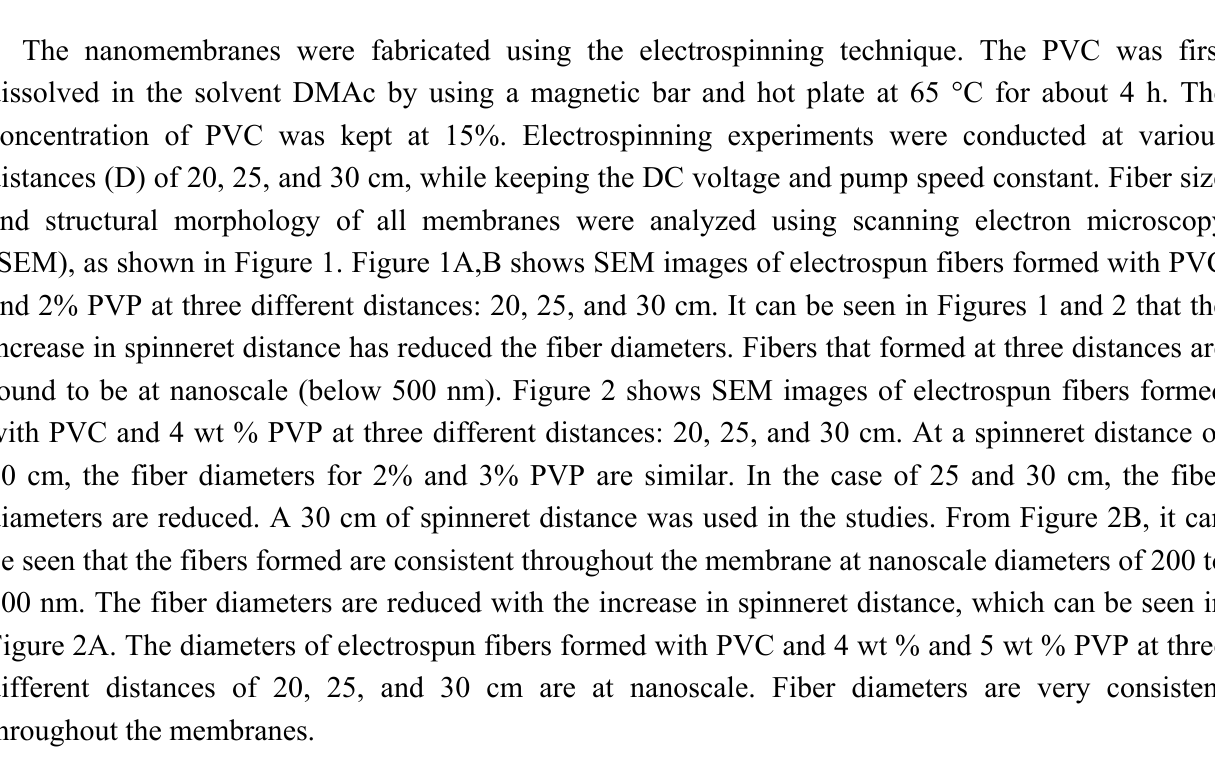
Figure 1. SEM images of PVC fiber with 2 wt % PVP at spinneret distance of ( a ) 20 cm and ( b ) 30 cm (scale bar is 10